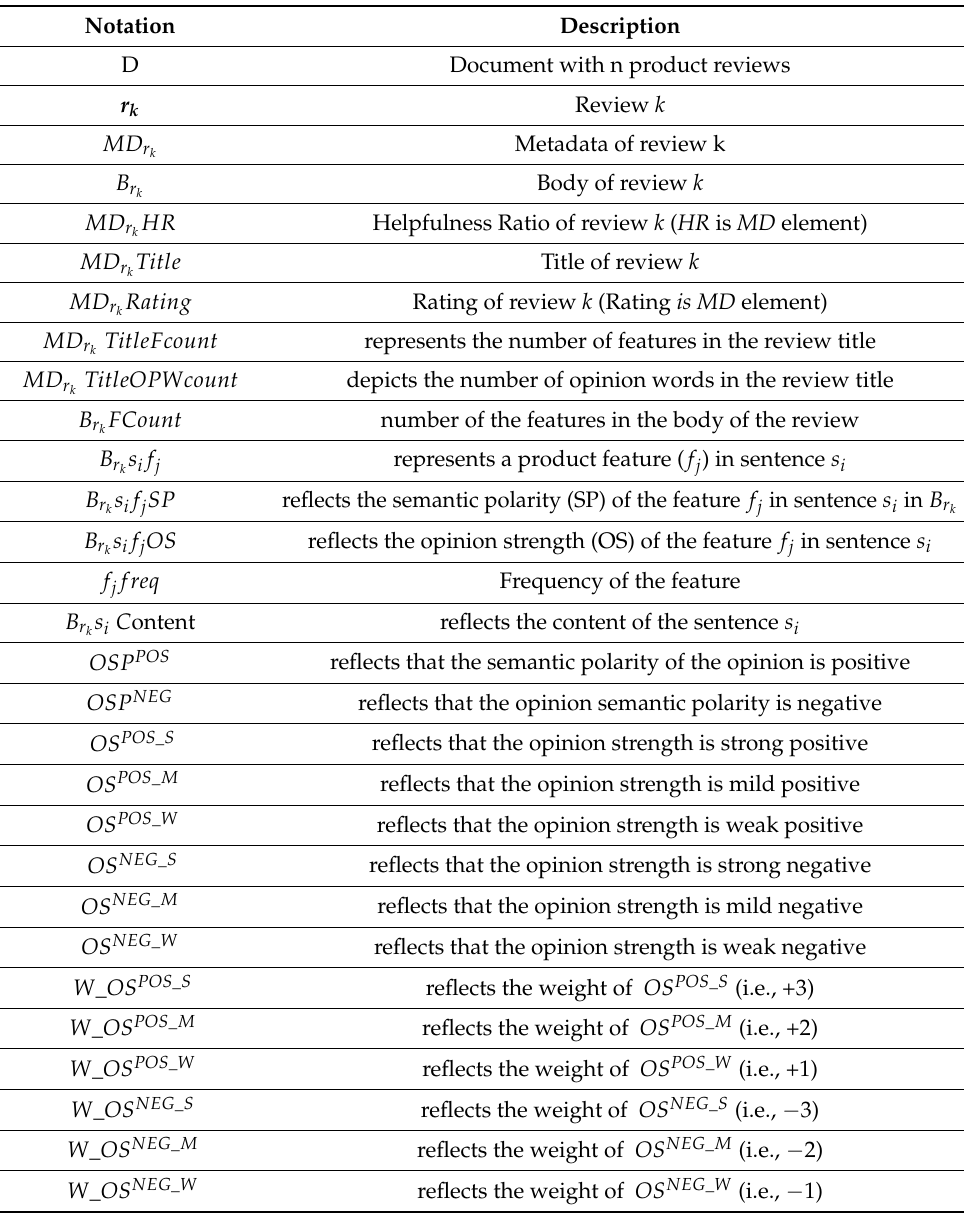
Table 1. Notations used in Review